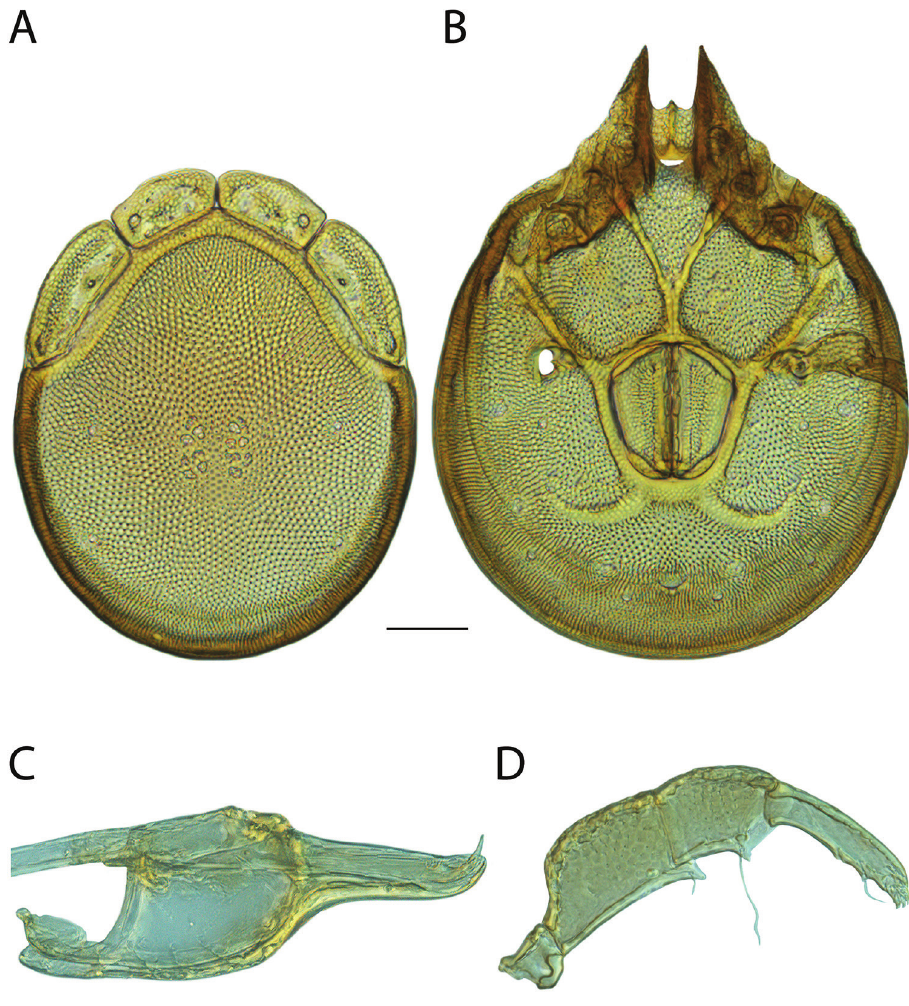
Figure 279. Torrenticola wiedenmanni sp. n. female: A dorsal plates B venter (legs removed) C subca- pitulum D pedipalp (setae not accurately depicted). Scale = 100